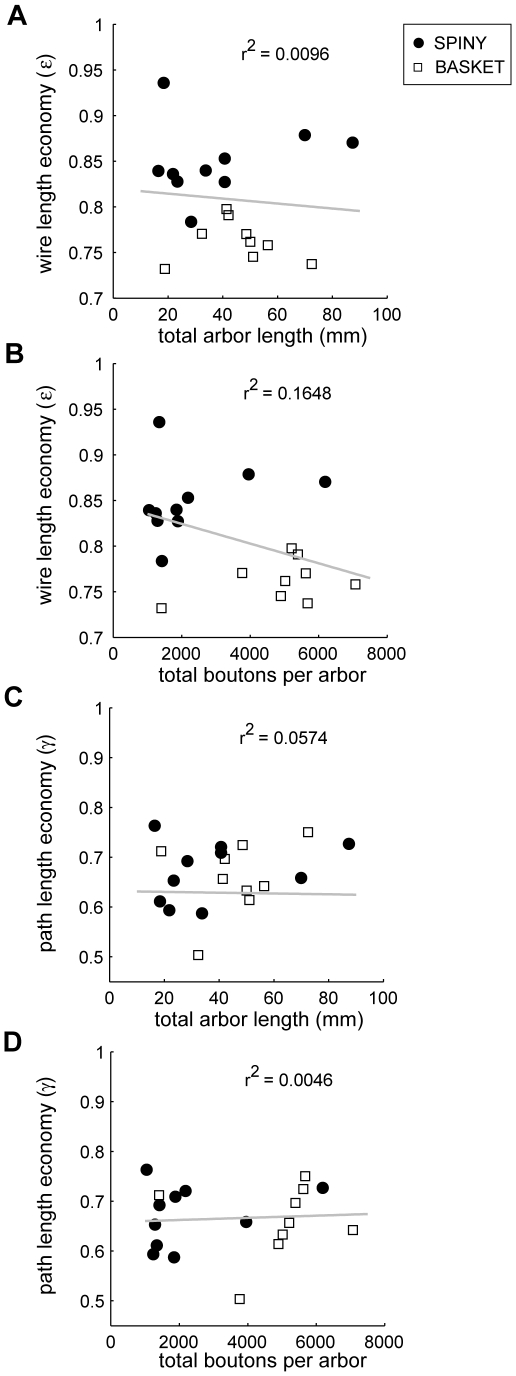
Wire length economy and path length economy uncorrelated with either arbor length or bouton number.(A) Wire length economy (ε) versus total axon arbor length (LAXON) (linear regression shown as solid grey line; slope  =  −0.000272 mm−1, intercept = 0.82, r2 = 0.0096), (B) Wire length economy (ε) versus total boutons per arbor (slope  = −1.08e−5 mm−1, intercept  = 0.85, r2 = 0.1648), (C) Path length economy (γ) versus total axon arbor length (LAXON) (slope = 0.0008 mm−1, intercept  = 0.63, r2 = 0.0574), and (D) Path length economy (γ) versus total boutons per arbor (slope  = 2.16e−6 mm−1, intercept  = 0.66, r2 = 0.0046) (n = 19). The lack of correlation implies they are scale-invariant economy measures.